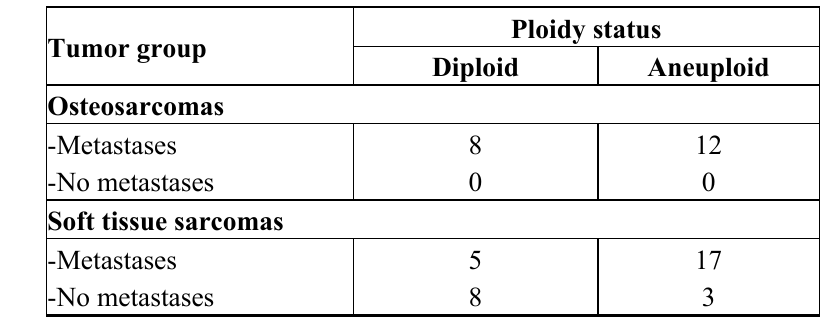
Table 4. The metastatic behavior of the sarcomas and the ploidy status of the primary